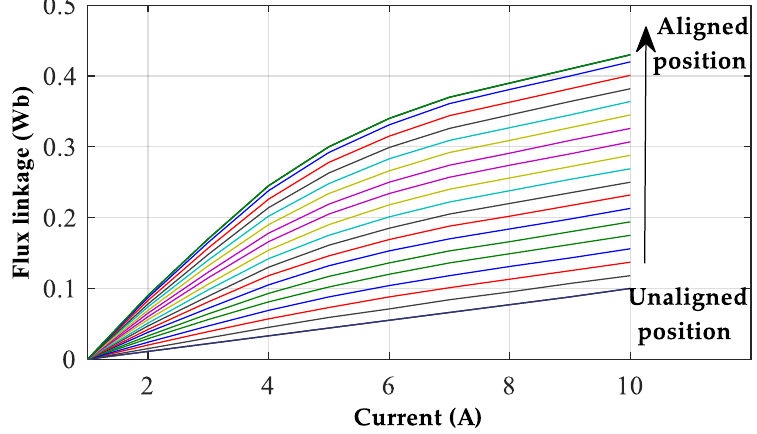
Figure 4. The 8/6 SRG magnetization characteristics versus current at different rotor